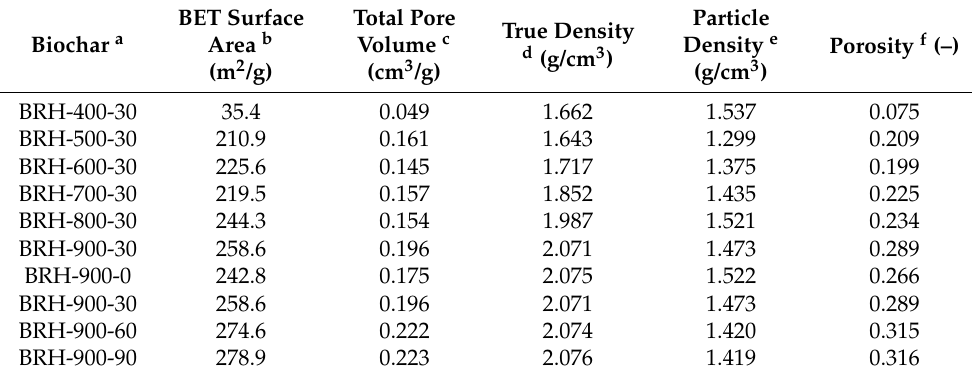
Table 1. Pore properties of resulting RH-based